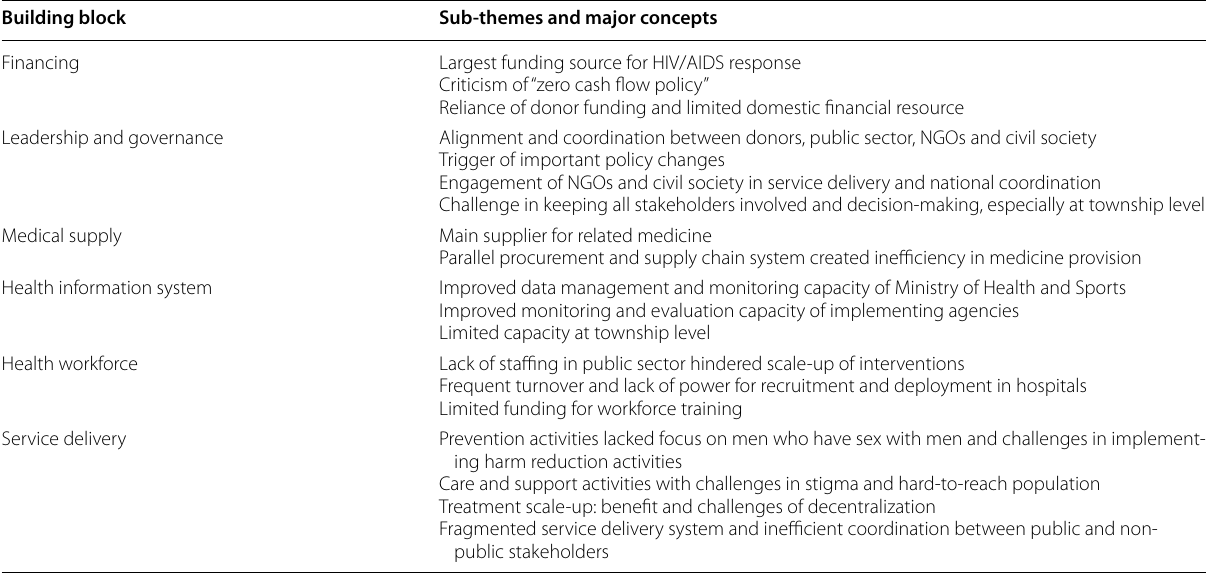
Table 1 Summary of result findings by health system building blocks Building